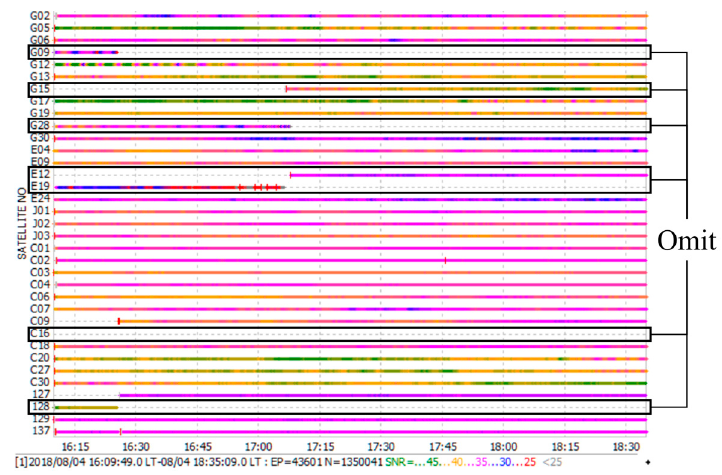
Figure 5. Example of the GNSS signal status from each satellite and the selection of the omitted satellites.